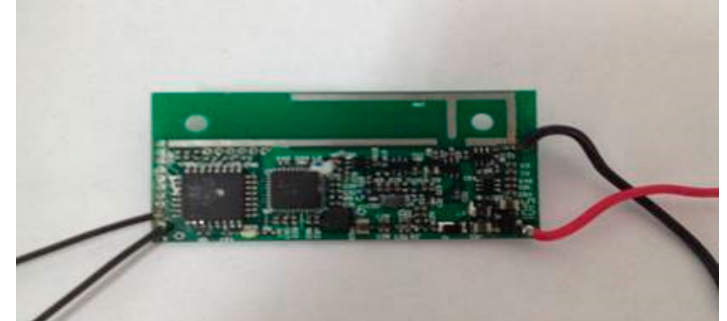
Figure 5. Wireless transceiver circuit.